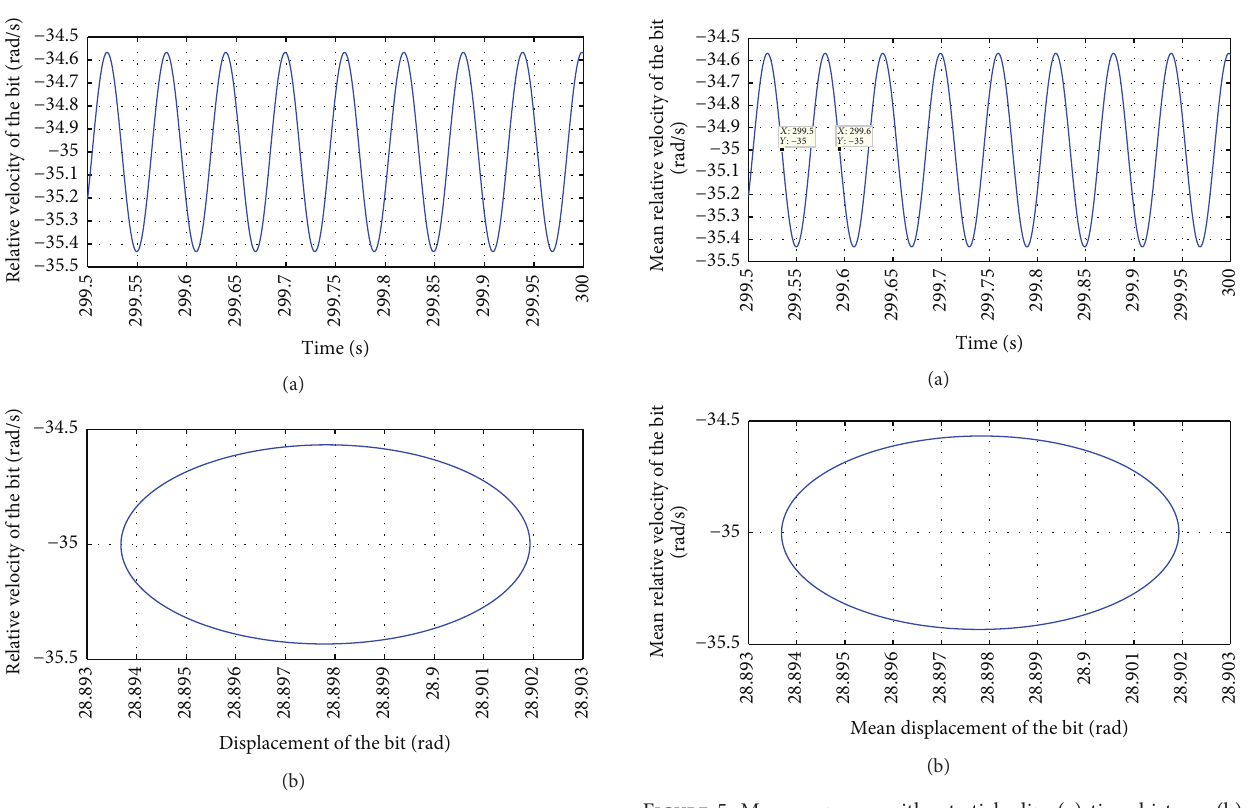
Figure 4: No stick-slip when the ground speed is 35 rad/s: (a) time history; (b) phase plane.